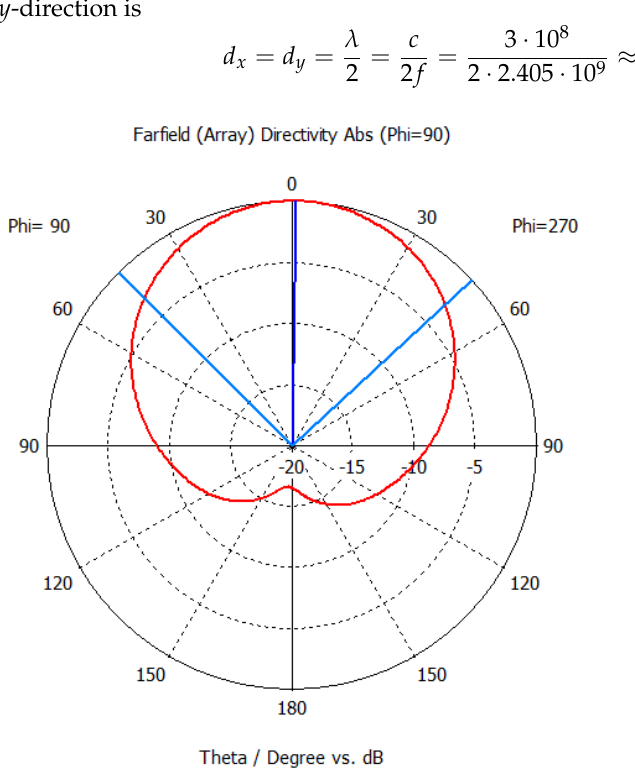
Figure 2. The diagram shows the directivity of one antenna array element.